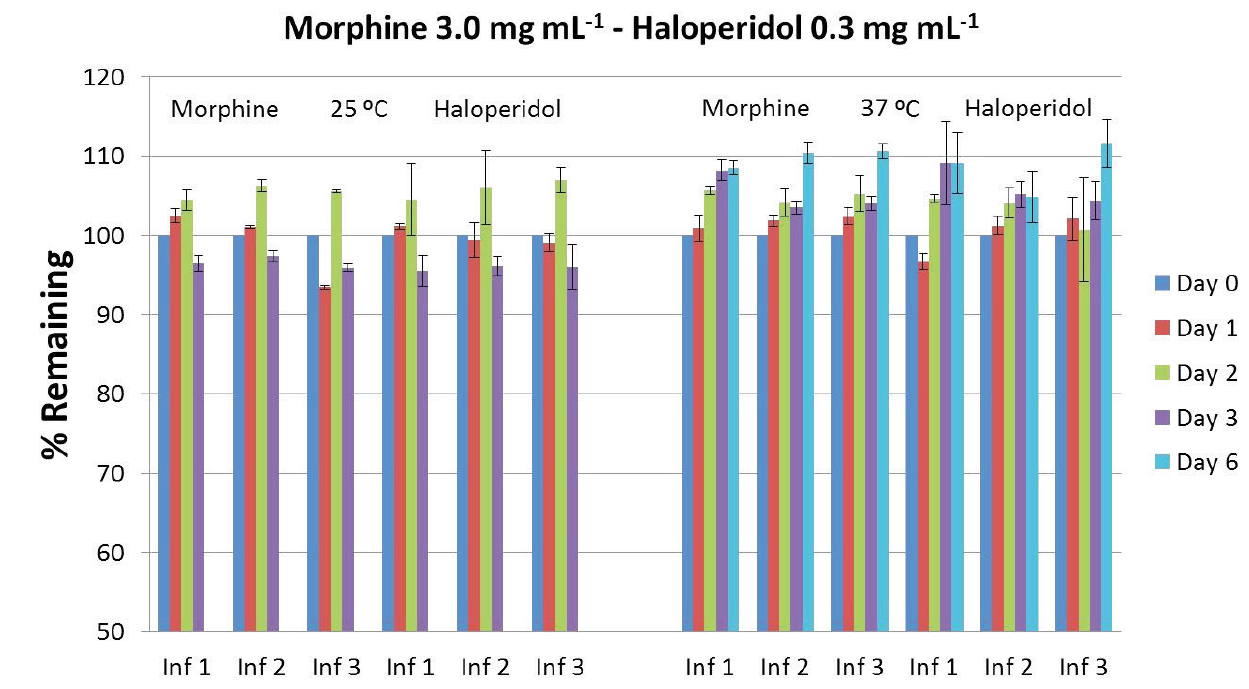
FIGURE 4 - Percentages of mixtures remaining at 25 ºC and 37